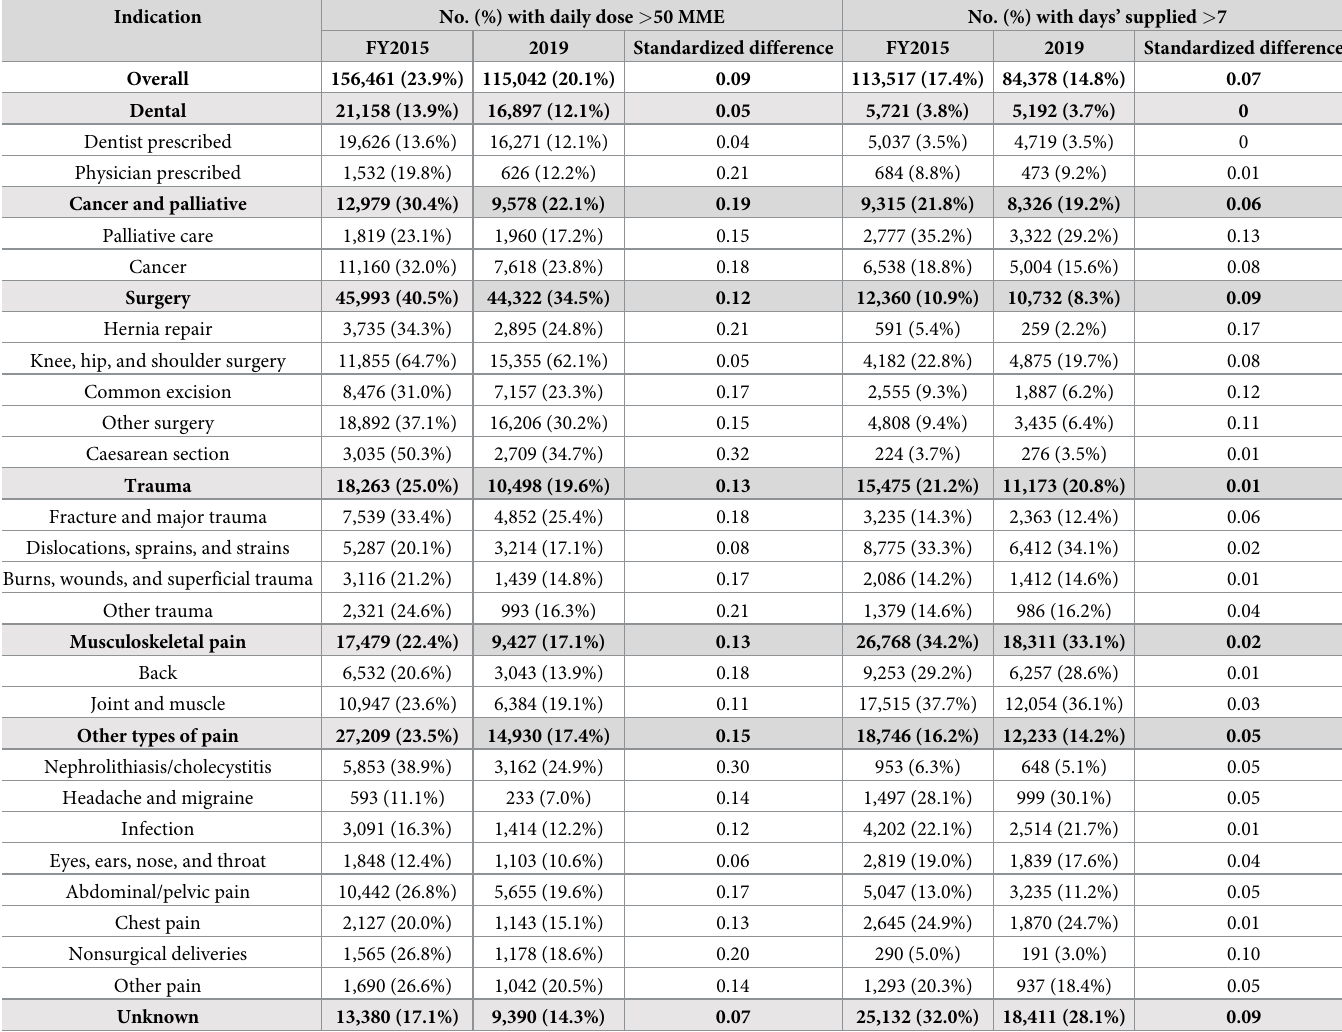
Table 3. Prevalence of high initial dose and duration among new opioid recipients, by indication. Fiscal year 2015 and calendar year